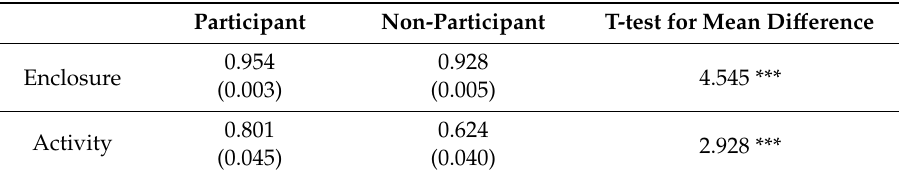
Table 2. Comparison of variables between participants and